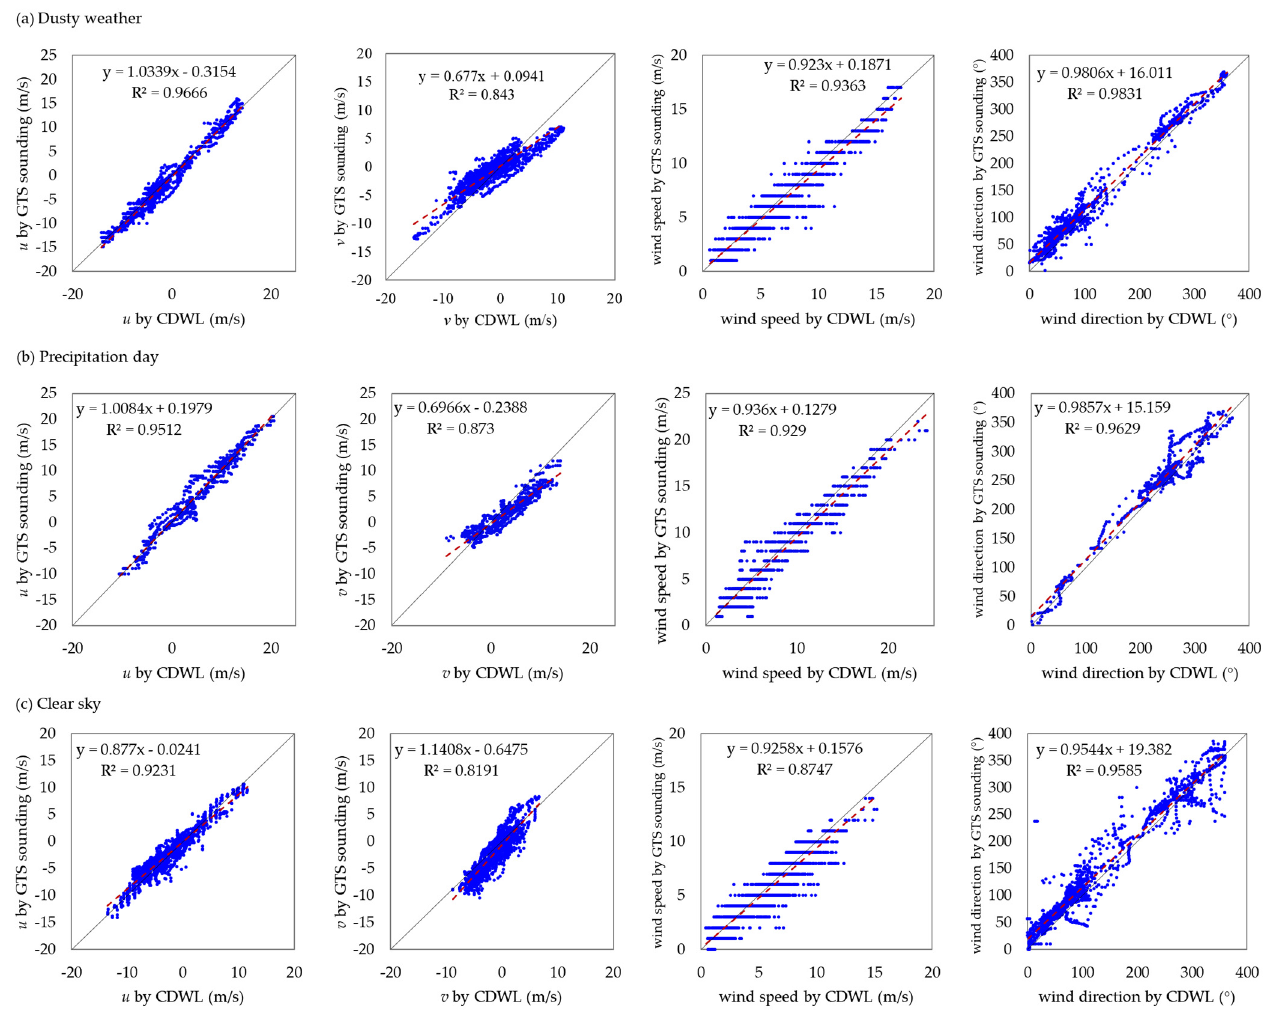
Figure 2. Comparison of u , v , wind direction, and wind speed data from CDWL and GTS sounding samples during ( a ) dusty weather, ( b ) precipitation, and ( c ) a clear sky in MF in August 2021. The regression line (red line) and reference line y = x (black line) are also shown. Table 1. The root mean square error (RMSE) of each element observed by CDWL and GTS sounding for different weather types.